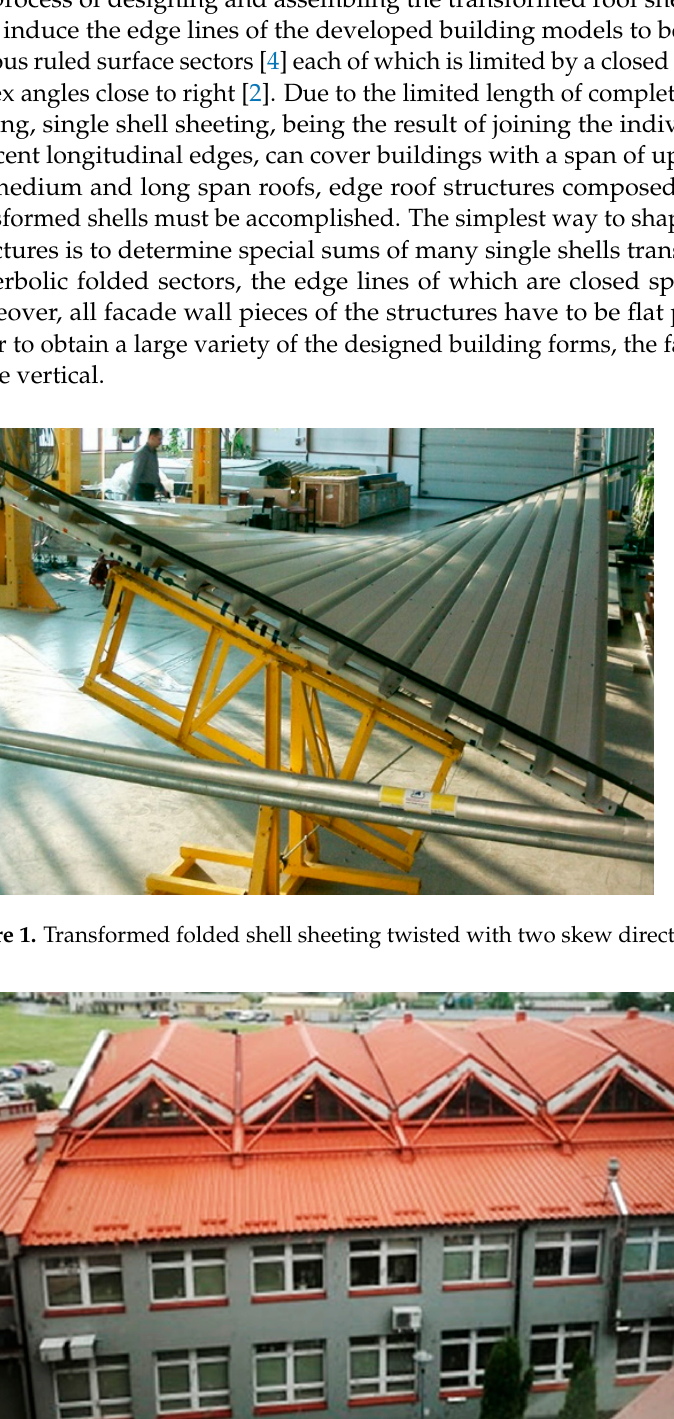
Figure 2. An experimental hall roofed with a regular shell structure.